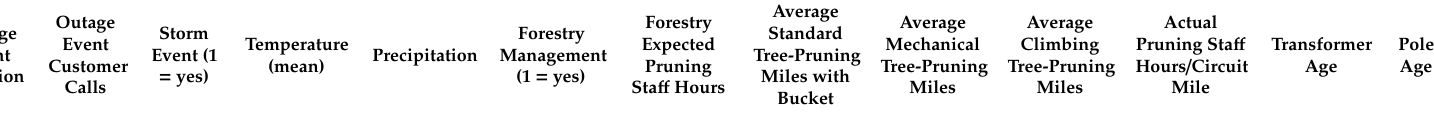
Table 4. Correlation